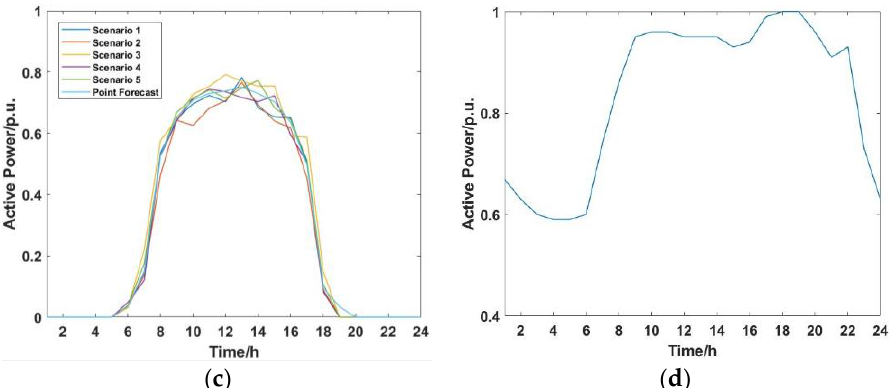
Figure 4. Point forecast and scenario-based probabilistic forecast containing: ( a ) wind power forecast; ( b ) PV forecast; ( c ) CSP solar thermal power forecast; ( d ) load demand.